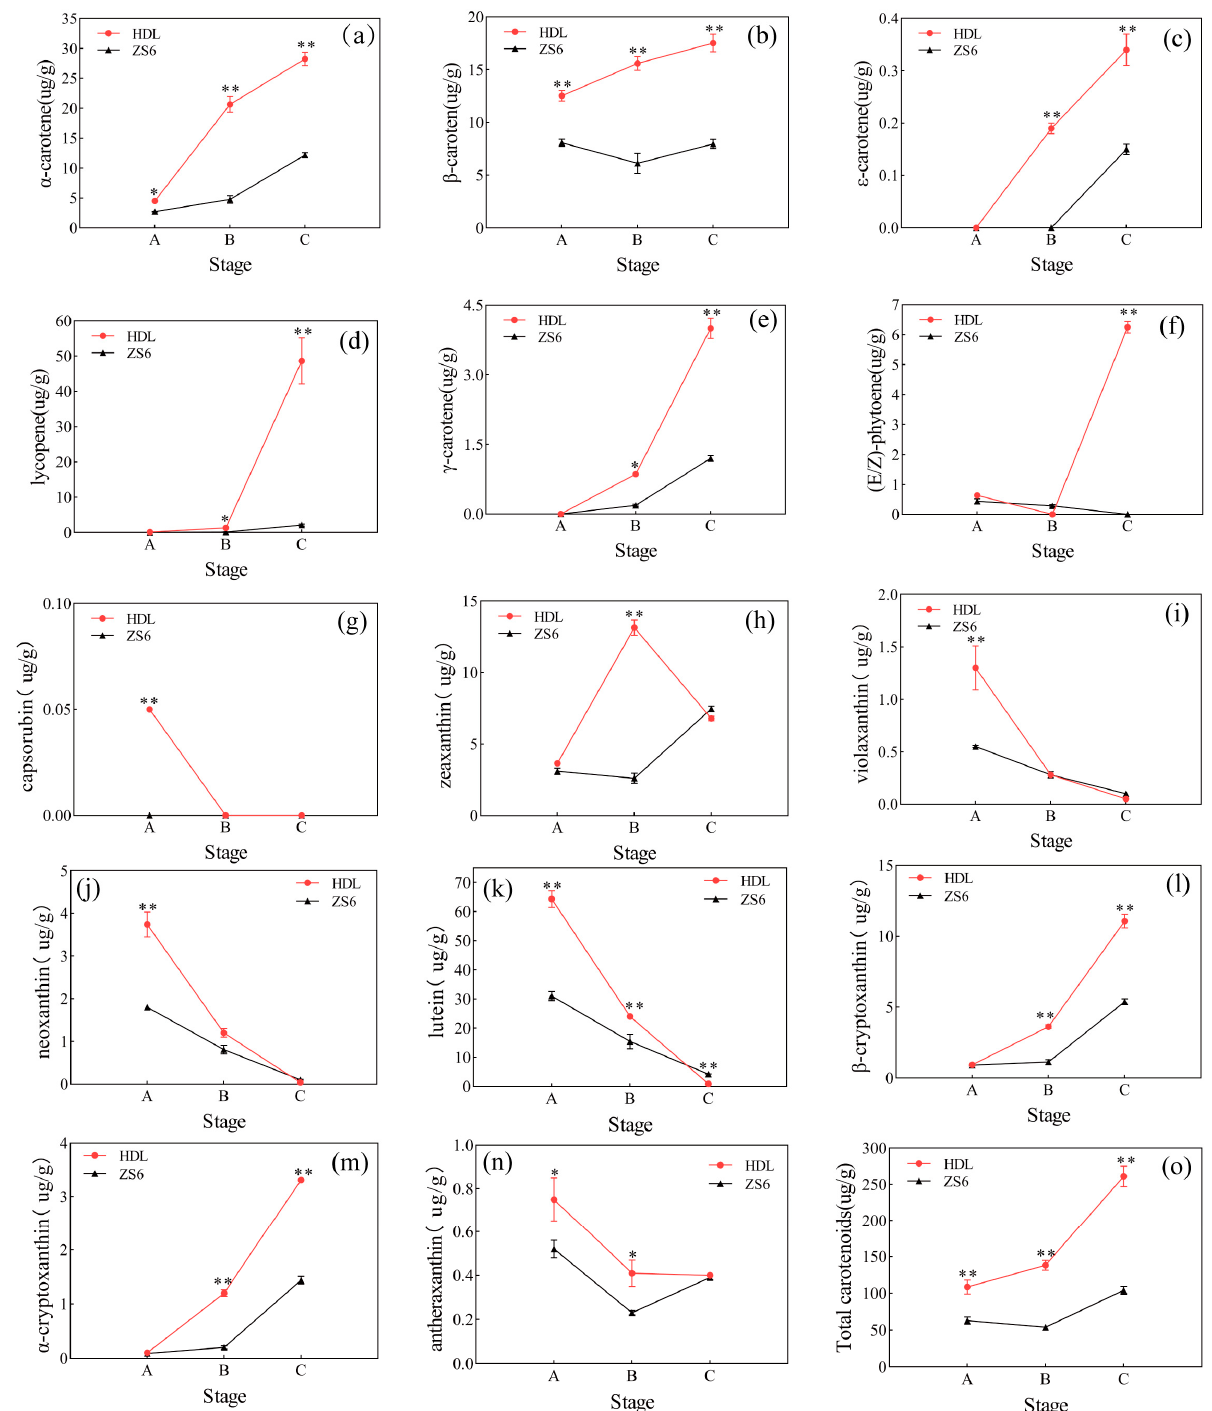
Figure 2. Changes in total and individual carotenoid contents of two persimmon cultivars through- out three growth phases. The subfigure ( a – o ) are α -carotene, β -carotene, ε -carotene, lycopene, γ -carotene, (E/Z)-phytoene, capsaicin, zeaxanthin, violaxanthin, neoxanthin, lutein, β -cryptoxanthin, α -cryptoxanthin, antheraxanthin and total carotenoids, respectively. A significant difference between the two persimmon cultivars at the 0.05 or 0.01 level throughout the same period is shown by the letters * or **,